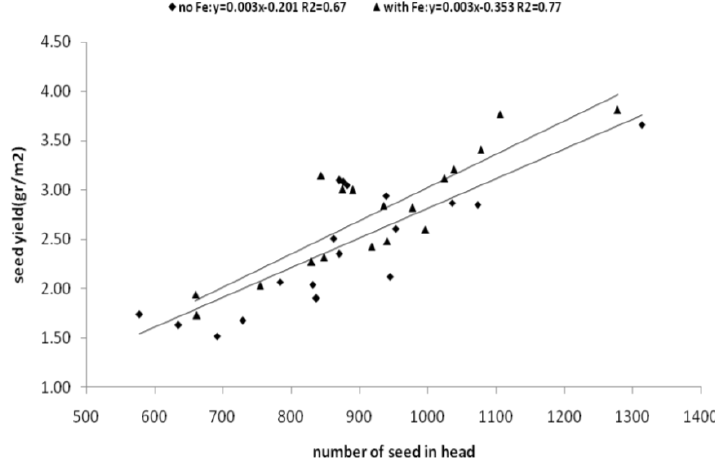
Fig. 1. Relationship between seed yield and number of seed per head in case of Fe (with Fe) and without Fe (no Fe) application in